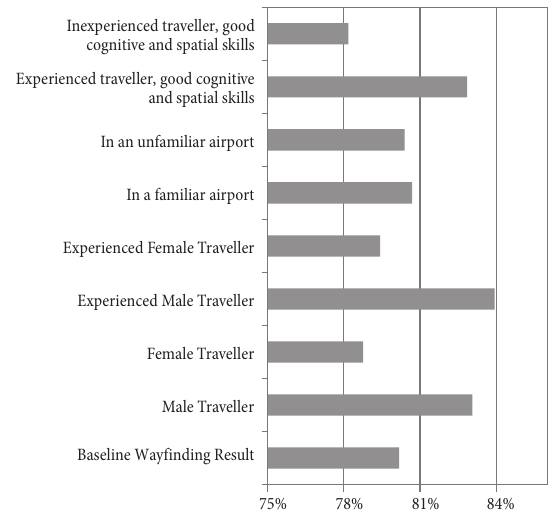
75% 78% Fig. 2. The Wayfinding Bayesian Network model tested several scenarios and their impact on wayfinding effectiveness in airports (the baseline result of the model shows that the overall probability of effective wayfinding in an airport is 80.18%; the changes in this result can be seen in the graph above depending on the scenario being tested)